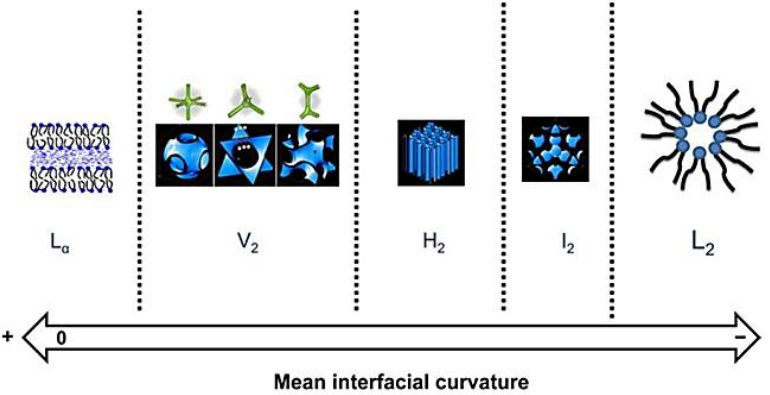
Figure 7. Schematic description for the nanostructure of LLCs depending on the mean interfacial curvature [42]. L α : lamellar phase; V 2 : inverted bio-continuous cubic phase; H 2 : inverted hexagonal phase; I 2 : inverted discontinuous cubic phase; L 2 : inverted micellar solution (Reprinted with permission from [42]. Copyright (2013) Elsevier)